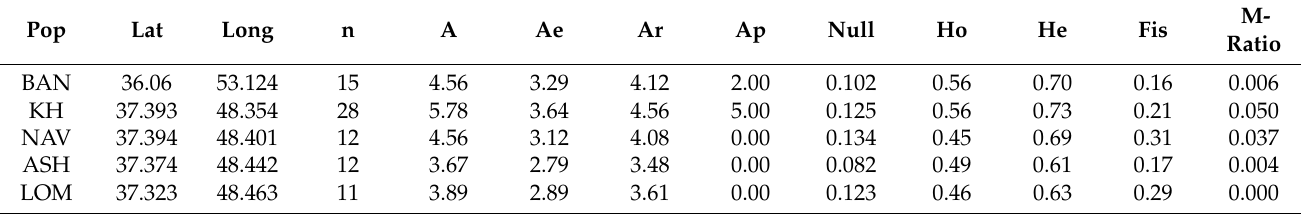
Table 2. Parameters of the genetic diversity of the studied populations. For abbreviations of the populations, see Table